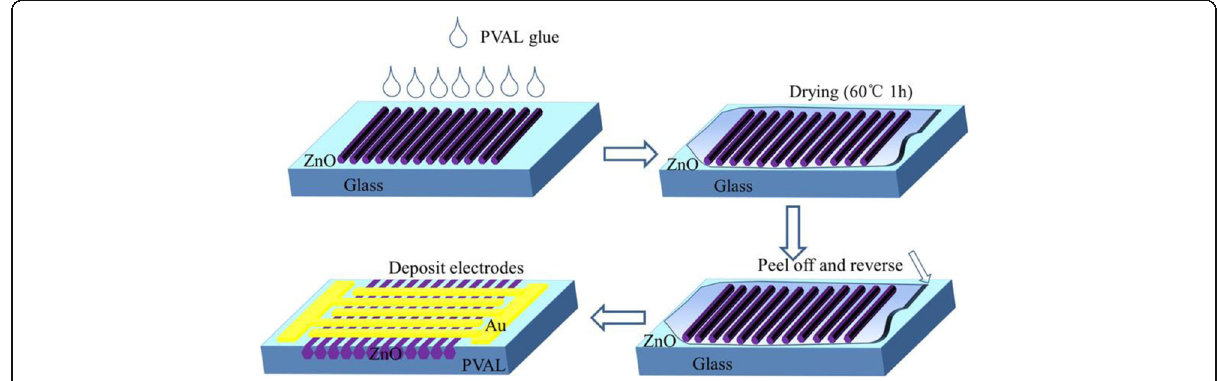
Fig. 2 The schematic of fabrication of the photodetector